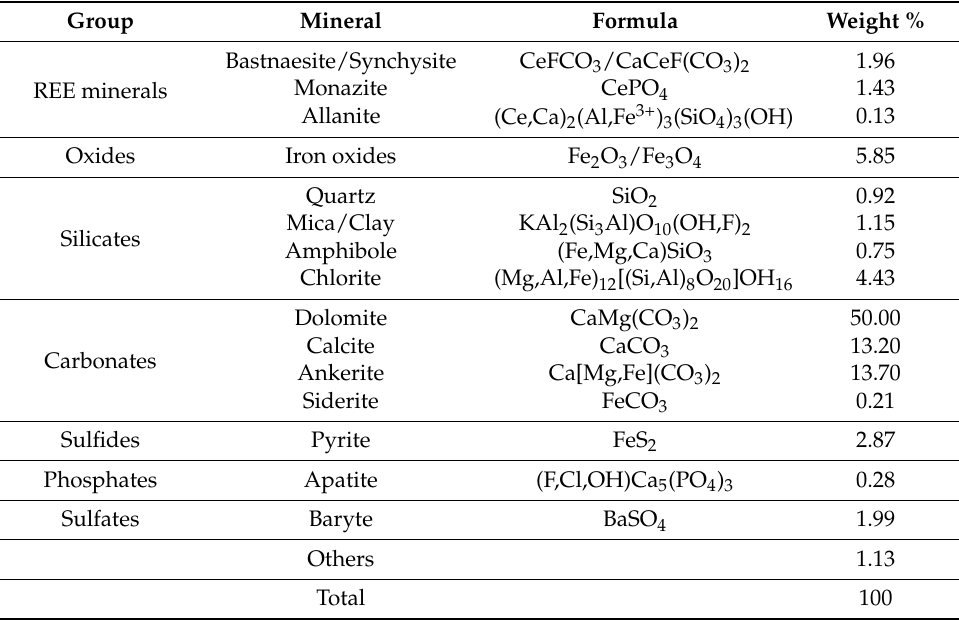
Table 1. Composition of Niobec rare earth element (REE) zone ore